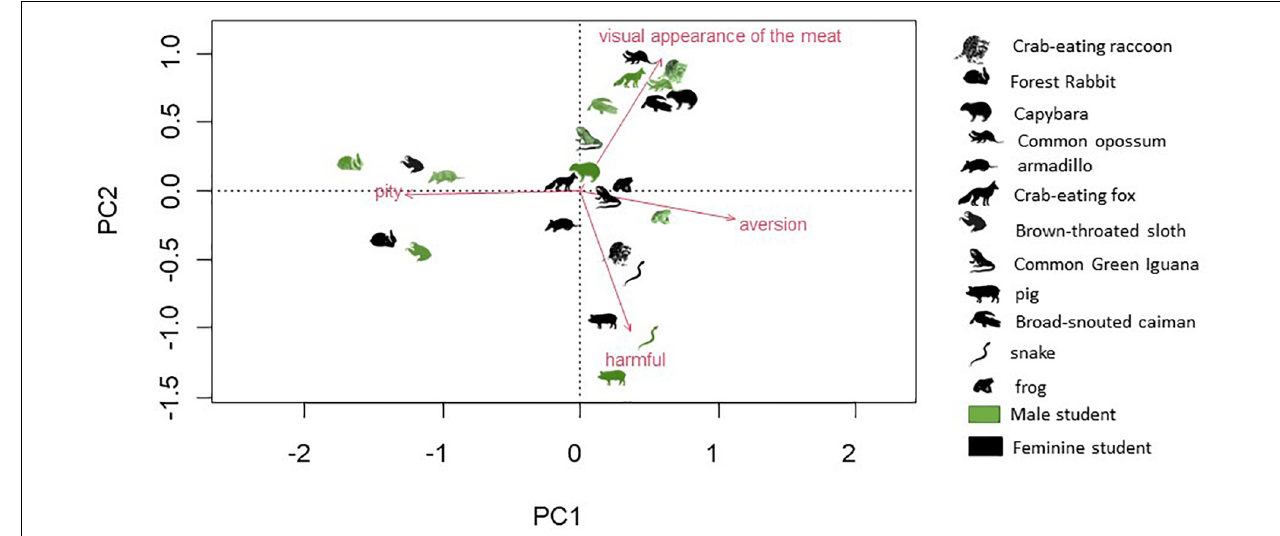
FIGURE 4 | Description of reject species in terms of motivations for rejection by female and male students obtained from a Principal Component Analysis